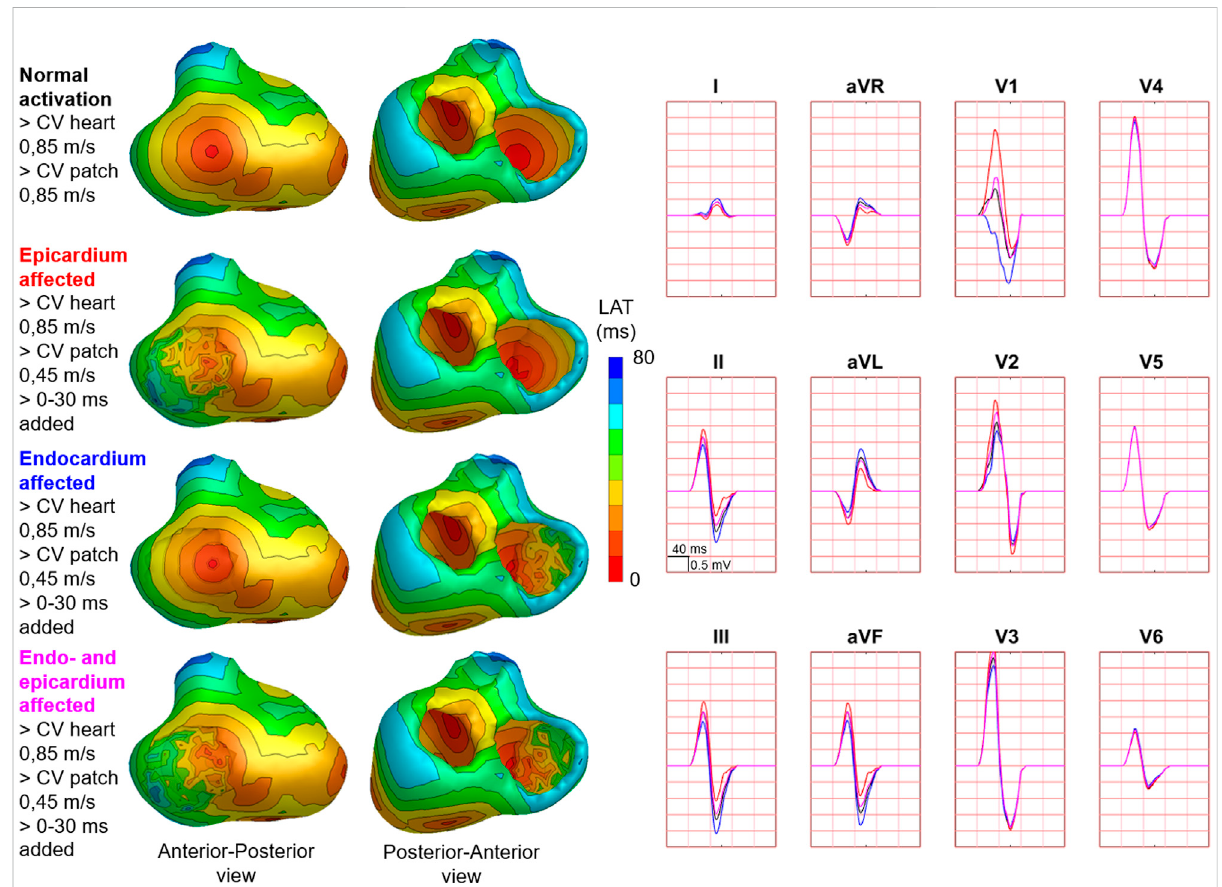
FIGURE 7 Effect of endocardial vs. epicardial disease on body surface potentials. Representative example of the effect of diseased endocardial and/or epicardial patch activation on body surface potentials. Activation sequences of the patches and ventricles are displayedfrom red (early) to blue(late) withisochronestepsof10 ms.AllsimulatedBSParedisplayedinthesimulated12-leadECG.ThecolorsintheECGcorrespondtothecolorsstatedin the left column with the simulation characteristics. With endocardial vs. epicardial patch location, the effect in leads with maximum effect was opposed. One cube in the 12-lead ECG corresponds to 40 ms (width) and 0.5 mV (height) as also indicated in lead